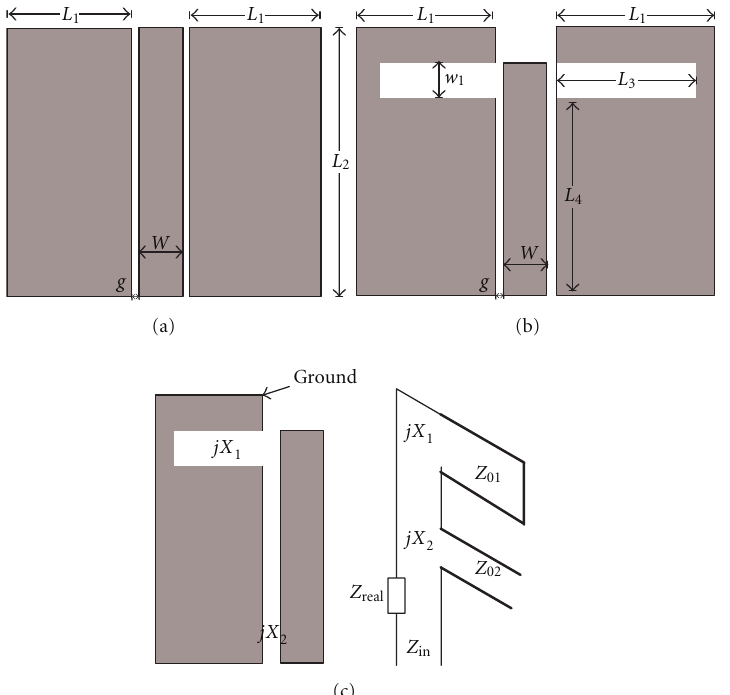
Figure 1: (a) A normal open-ended CPW-fed transmission line. (b) The geometry of antenna 1 and (c) The equivalent transmission line circuits for antenna 1.